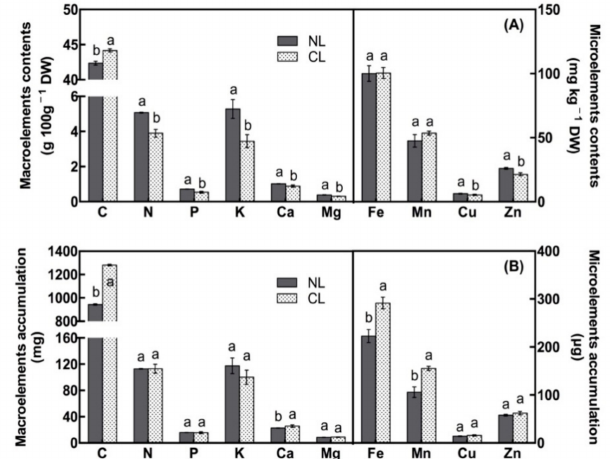
Figure2. E ff ectsofcontinuouslightandnormallightonnutrientelementcontents; ( A )andaccumulation; ( B ) of hydroponic lettuce. Di ff erent letters indicate a significant di ff erence among treatments at p < 0.05.